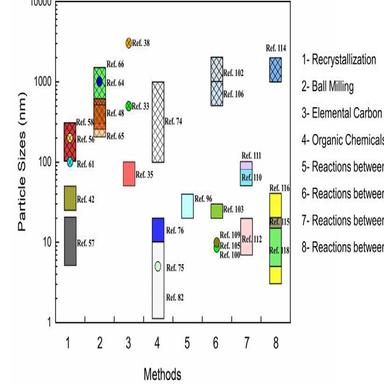
Summary of particle sizes of Li2S synthesized by eight methods. The non-patterned symbols imply primary particles, and the patterned symbols imply secondary particles. The length of rectangles corresponds to the particle sizes, while the circles mean that the particle sizes are reasonably uniform.